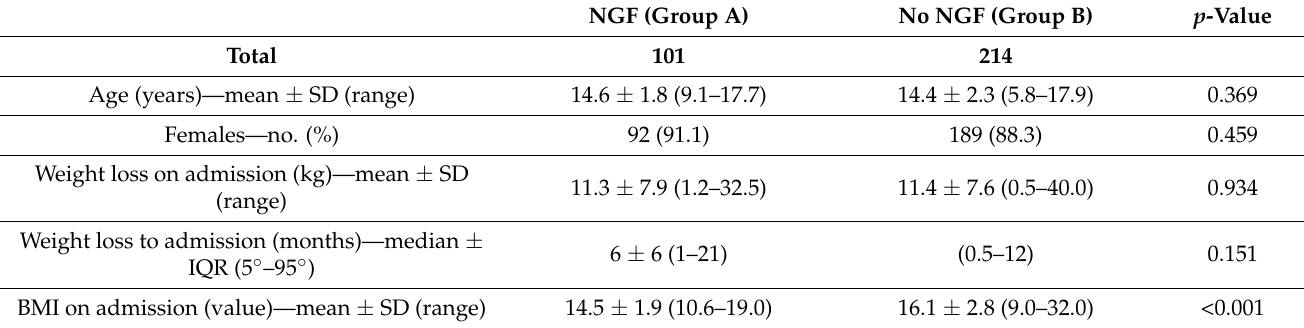
Table 2. Comparison of patients treated and untreated with NGF *.